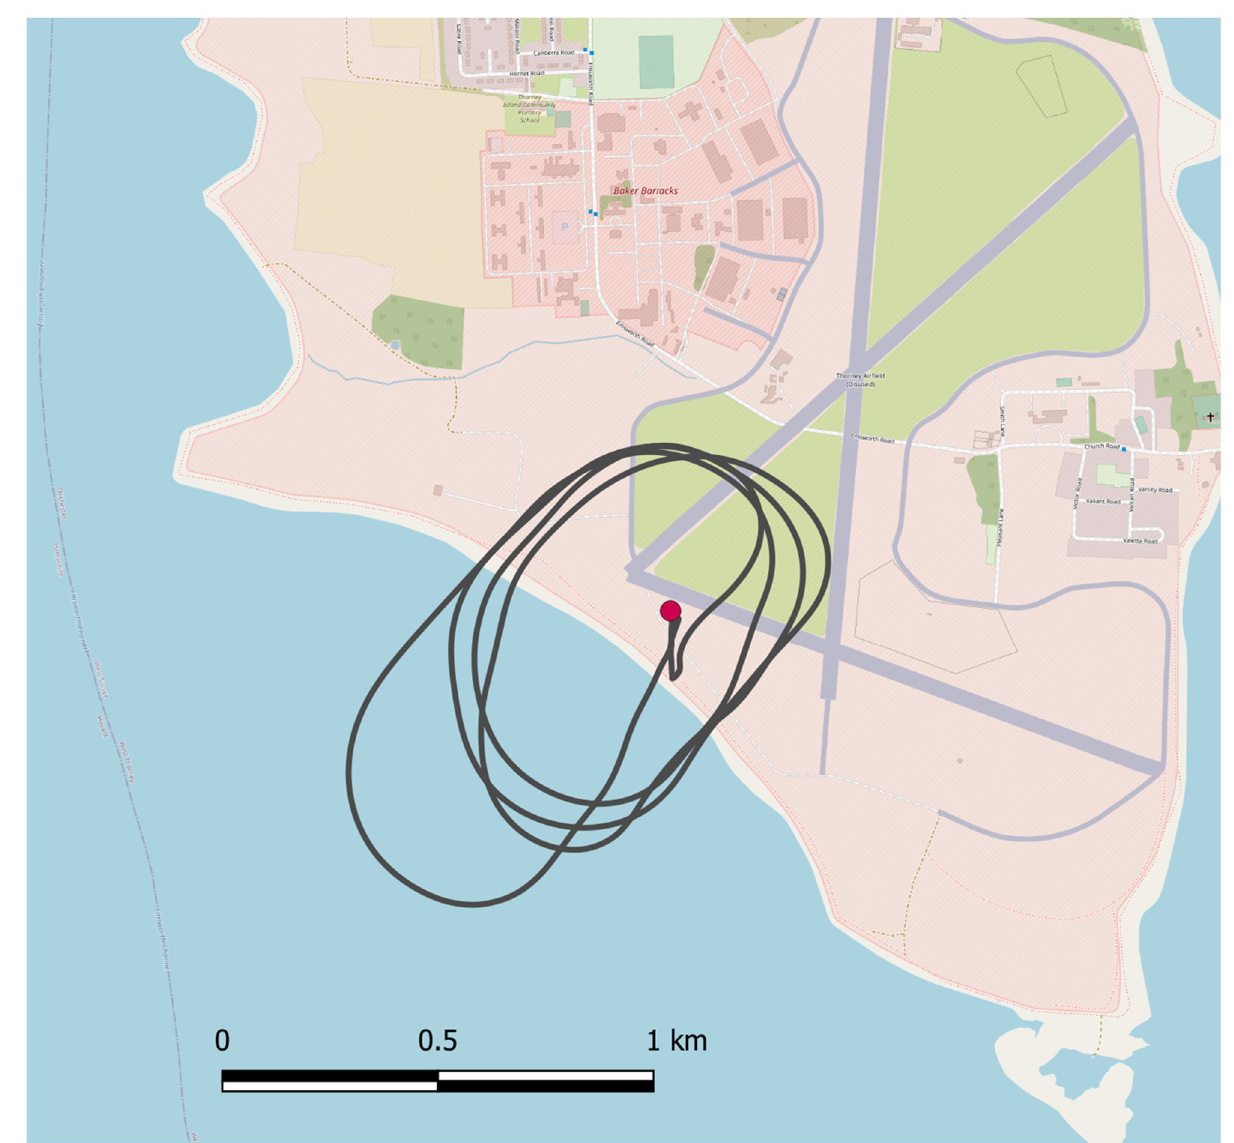
Fig 6. Flight path of the test flight in the second trial, based at the military base at Thorney Island. Distance flown was 10.9km. Base map and data from OpenStreetMap and OpenStreetMap Foundation.